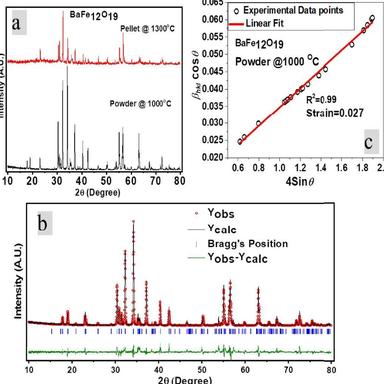
(a) XRD patterns of BHF powder sample annealed at 1000 �C and pellet sintered at 1300 �C. (b) The XRD patterns with Rietveld refinement of BHF powder annealed at 1000 �C. (c) The Williamson-Hall plot for the XRD pattern obtained for powder sample.